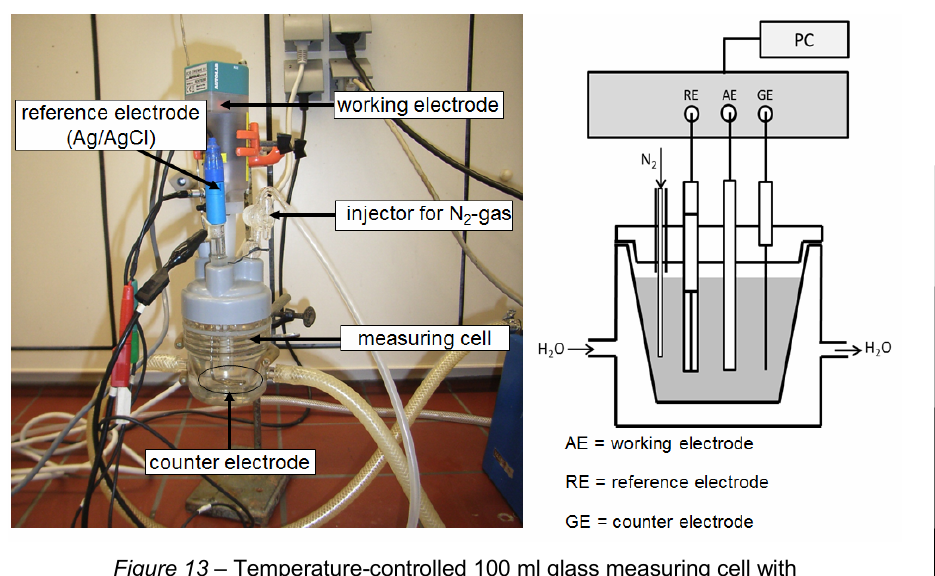
Figure 13 – Temperature-controlled 100 ml glass measuring cell with a three electrode setup Рис . 13 – Стеклянная измерительная ячейка − 100 ml с контролируемой температурой и тремя